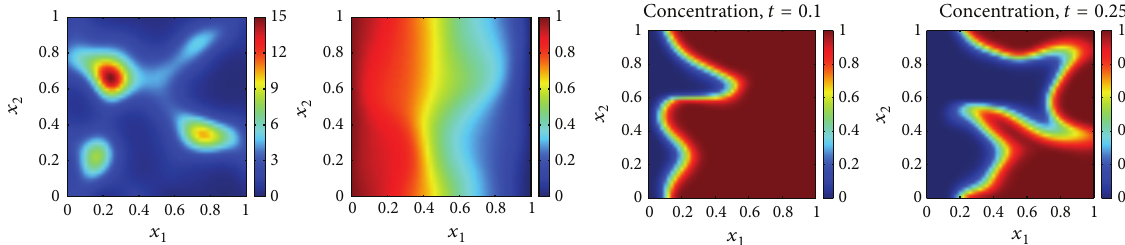
Figure 4: Typical results of flow and transport simulations for one realization 𝜔 1 . From left to right: permeability field 𝐾(𝑥,𝜔 1 ) , pressure solution 𝑝(𝑥,𝜔 1 ) , and concentrations 𝑐(𝑥, 𝑡,𝜔 1 ) at different time steps.